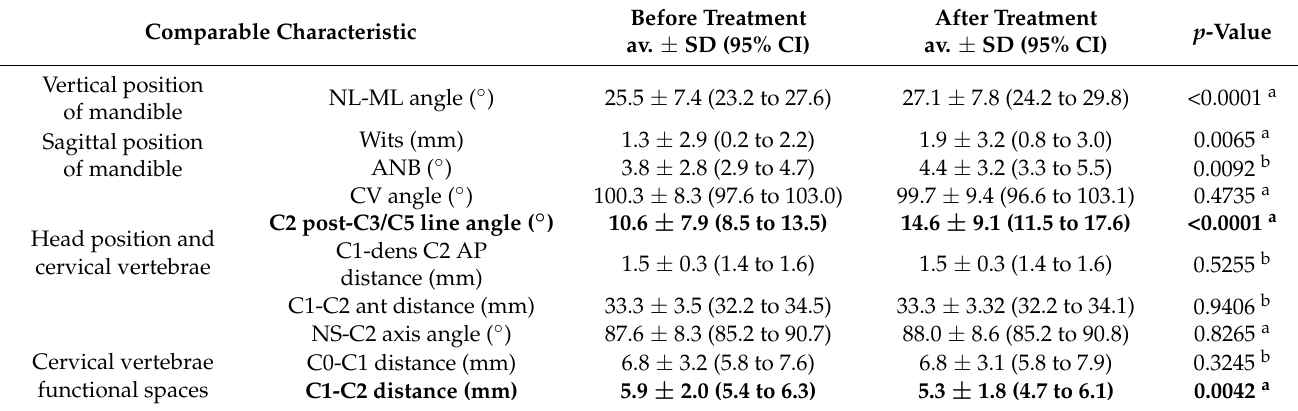
Table 5. Assessment of the craniovertebral and craniomandibular changes in cephalometric images after occlusal splint therapy combined with physiotherapy in patients diagnosed with temporo- mandibular joint